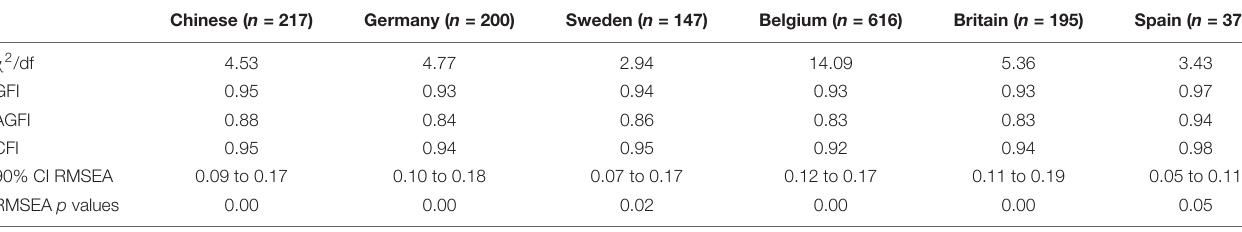
TABLE 2 | Fitness statistics for the confirmatory factor analyses of OSS-6.